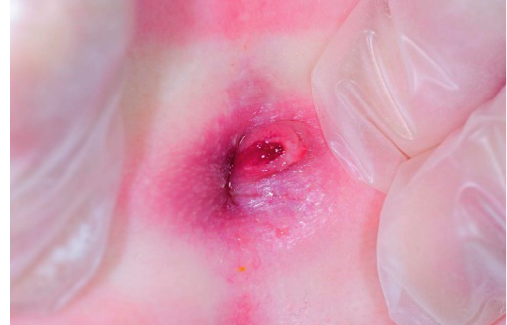
Figure 1: Atypical perianal lesion.